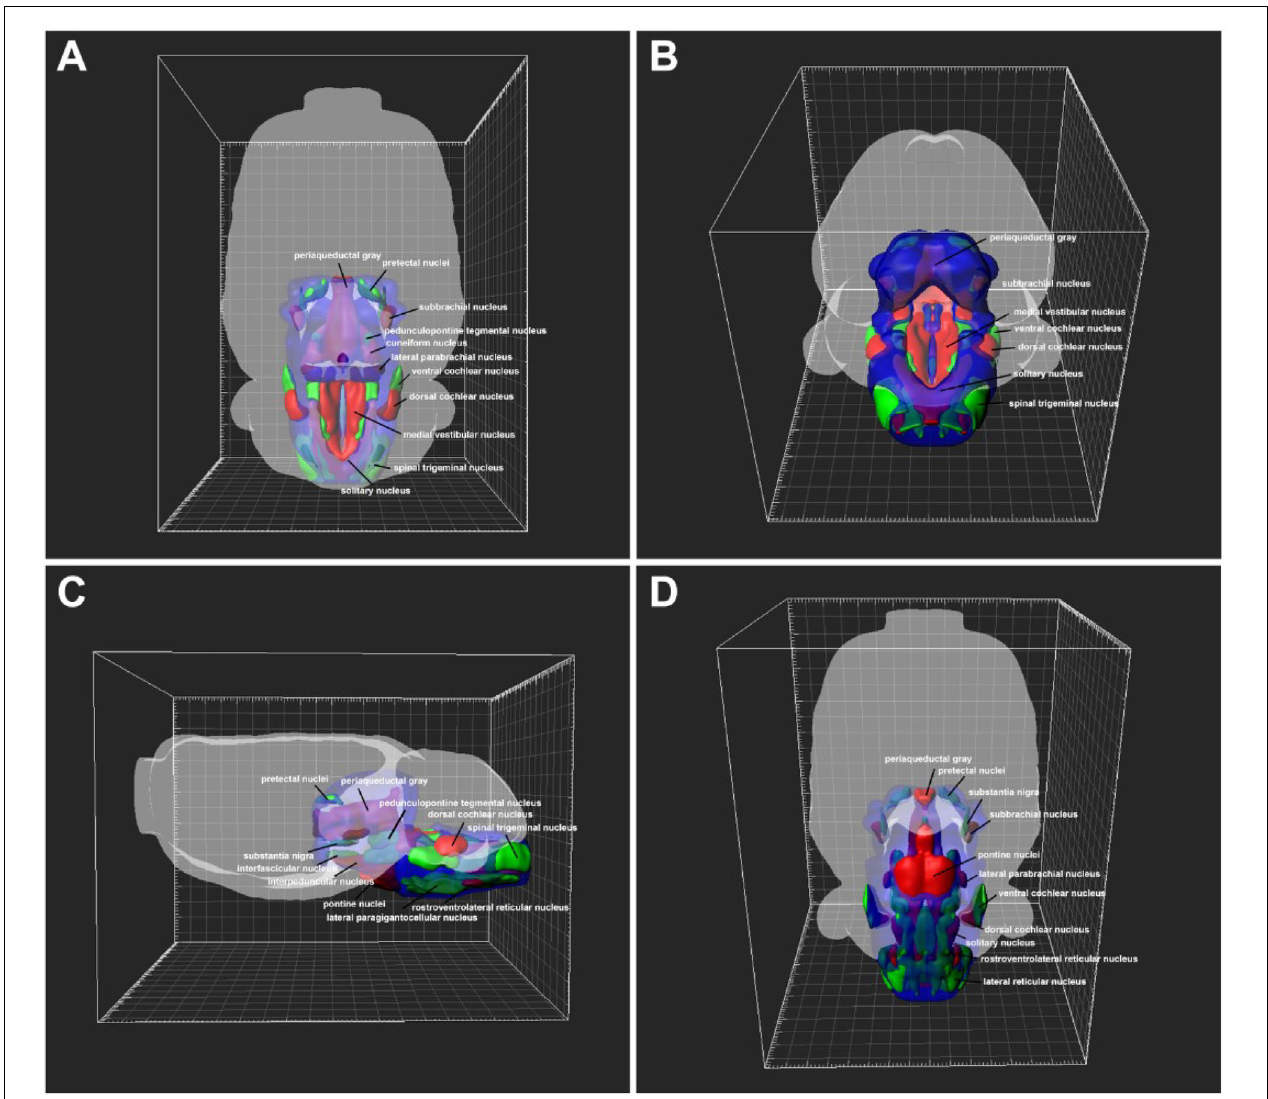
FIGURE 12 | 3D view of the patterns of the brainstem and spinal cord connections to the CSF-contacting nucleus. (A) Dorsal view, (B) posterior view, (C) lateral view, (D) ventral view. The red areas indicate strong connections; green areas indicate moderate connections; and blue areas indicate weak connections to the CSF-contacting